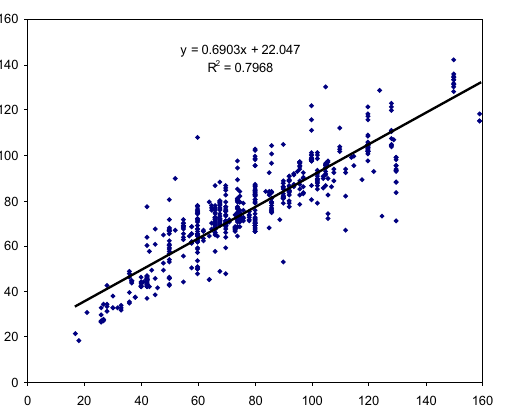
y = 0.5168x + 38.528 R 2 = 0.5141